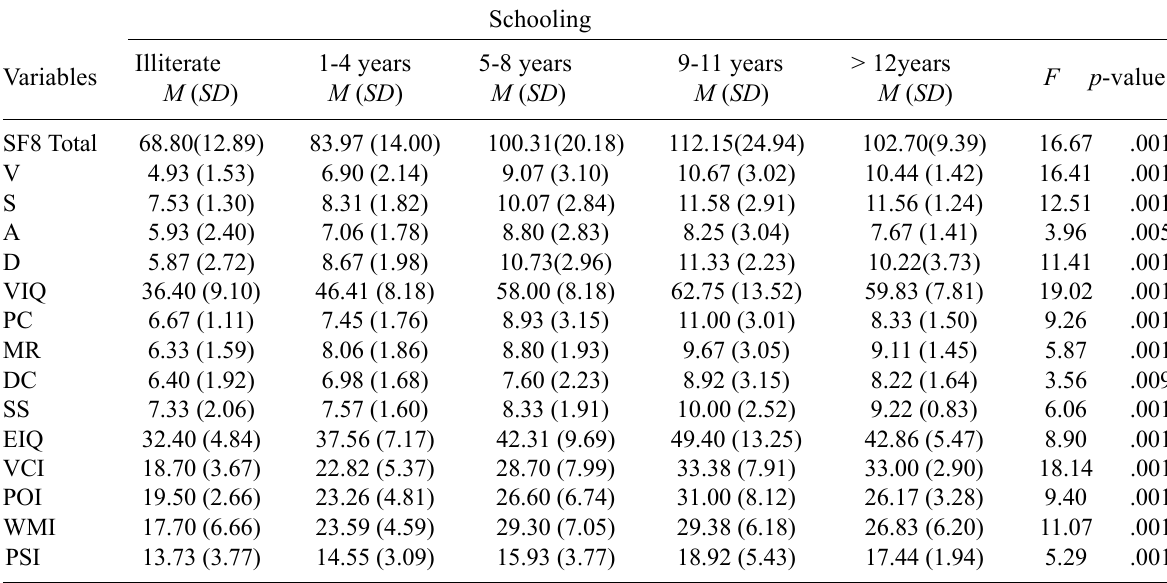
Cognitive Performance of Group 1 According to Schooling